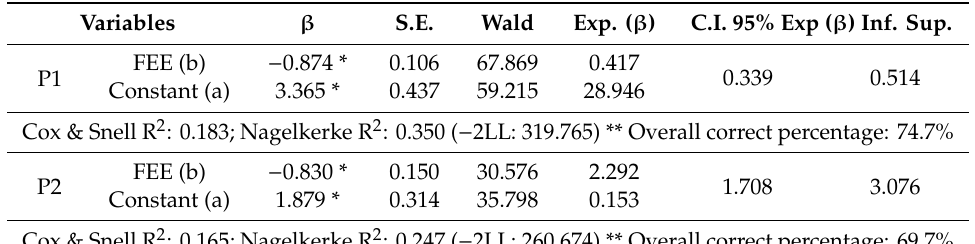
Table 18. Logistic regression results for WTPEF in the HNP